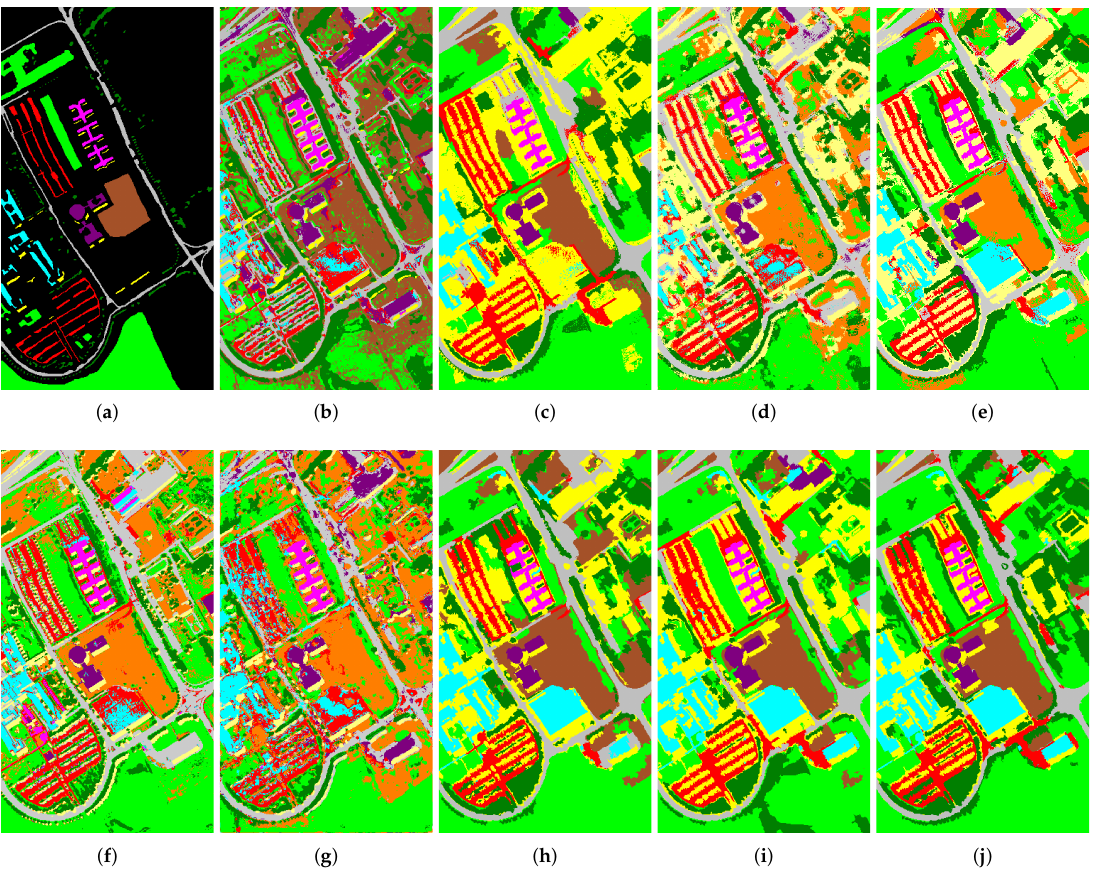
Figure 3. Classification results of University of Pavia (UP) with 15 training samples per class. ( a ) Ground-truth; ( b ) SVM-CK; ( c ) SpMK; ( d ) ANSSK; ( e ) RMK; ( f ) EMAP; ( g ) AIP; ( h ) ASMSSK; ( i ) LRCISSK; ( j )